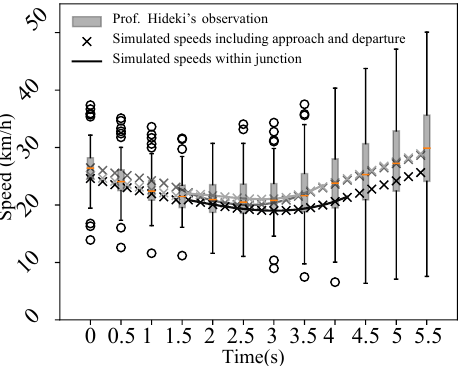
Figure 6. Comparison of free-flow speeds of thee car agents and field observations by Professor Hideki